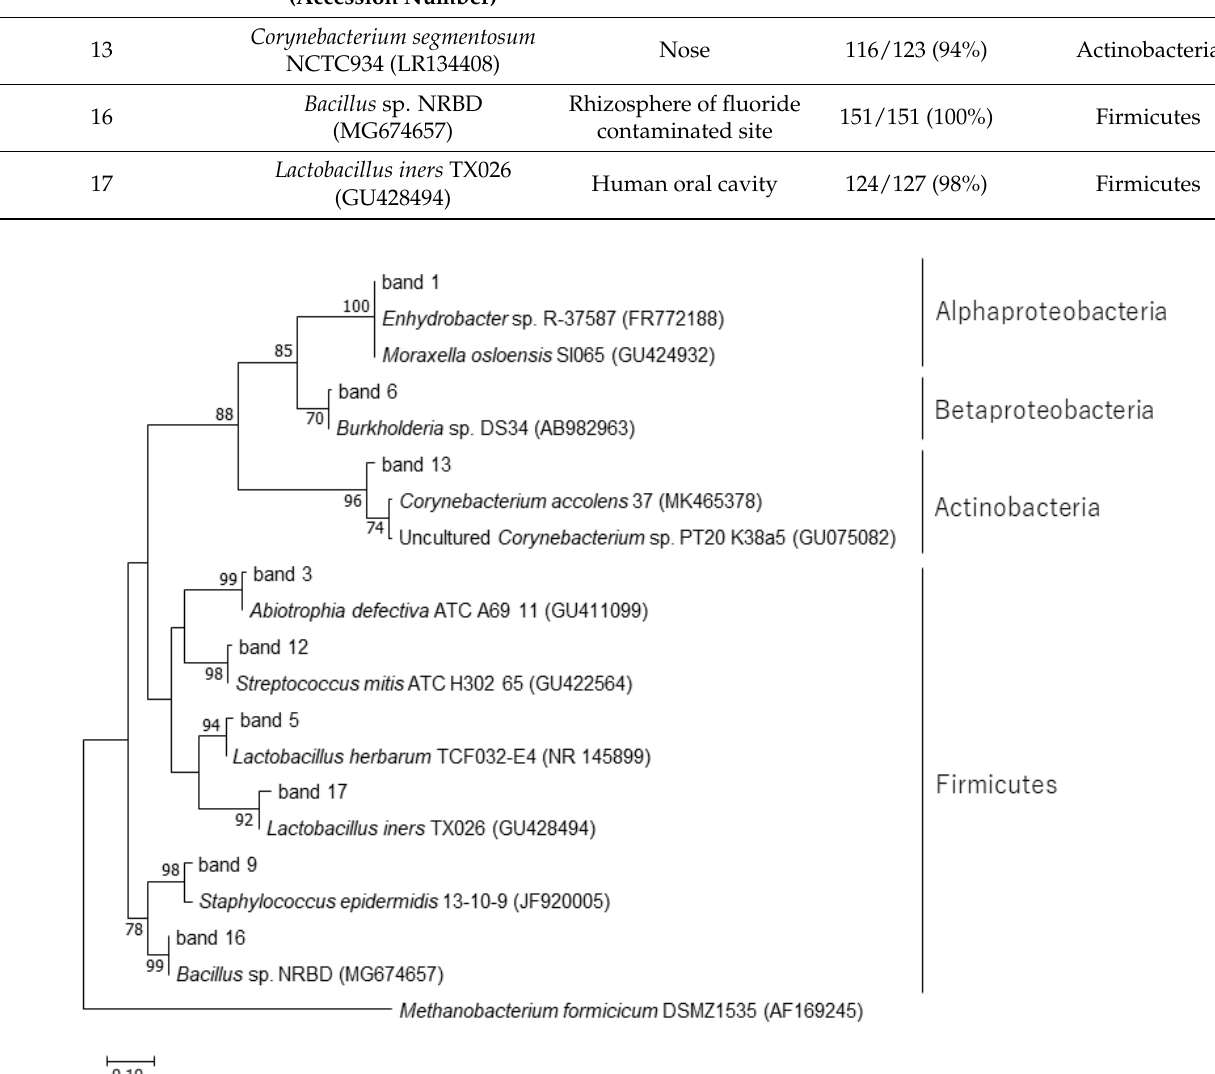
Figure 5. Phylogenetic analysis of the 16S rRNA gene sequences recovered after excision of DGGE bands. The tree was constructed by the maximum-likelihood method with Methanobacterium formicicum DSMZ1535 (AF169245) as an outgroup. Reference sequences were retrieved from the GenBank (NCBI) database. Bootstrap values were calculated from 1000 replicates, and bootstrap values of 50% or greater are shown on branches. The scale bar represents 0.10 changes per sequence position.